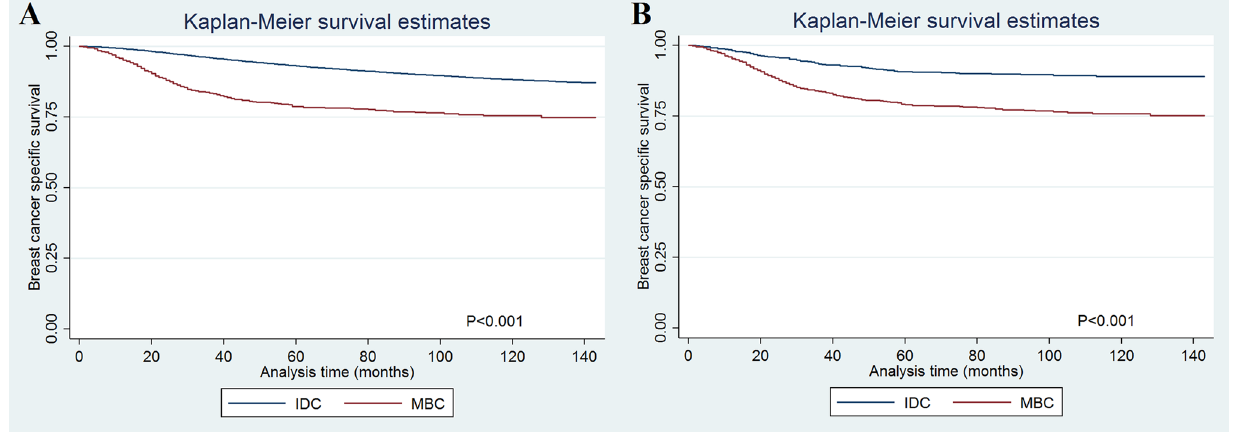
Figure 1. The breast cancer-specific survival between invasive ductal carcinoma and metaplastic breast carcinoma before ( A ) and after ( B ) propensity score matching.